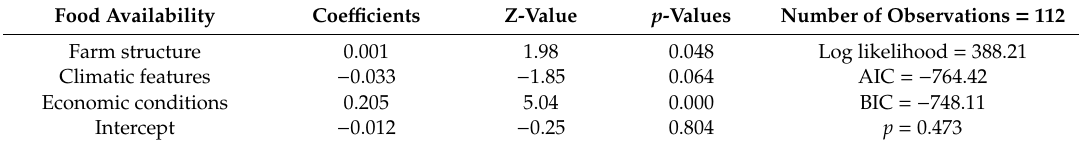
Table 7. The estimated results of a spatial lag model regression; Source: own